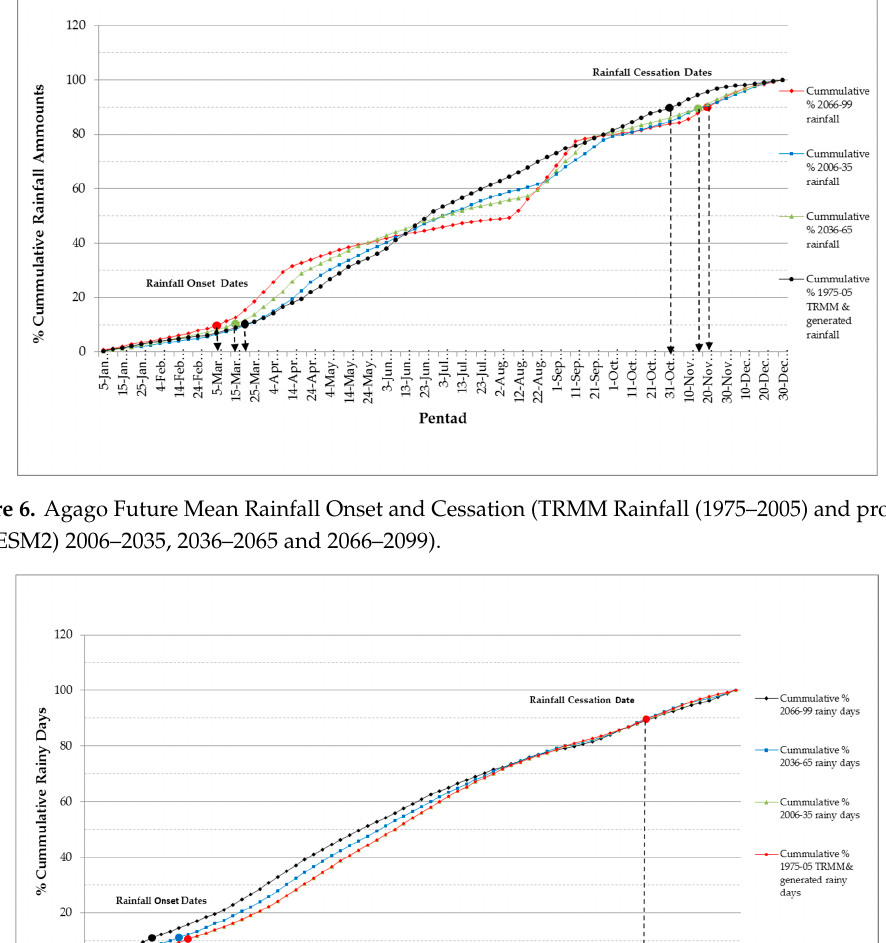
Figure 5. Agago Future Mean Rainfall Onset and Cessation for Rainy Days (TRMM Rainfall (1975-